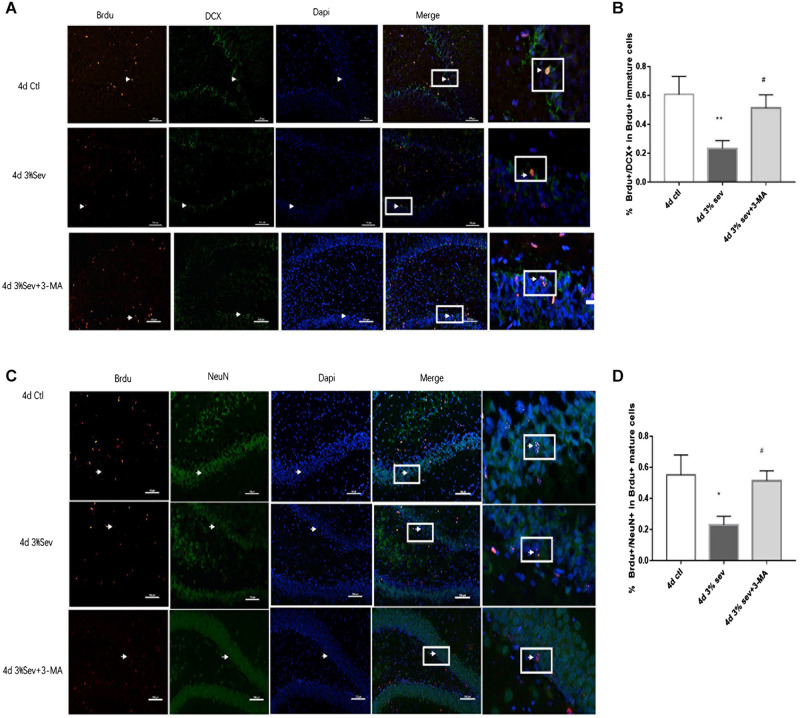
(A) LC3B inhibitor alleviated sevoflurane-induced decrease of differentiation into DCX in BrdU+ immature cells 4 days after anesthesia. (C) LC3B inhibitor alleviated sevoflurane-induced decrease of differentiation into NeuN in BrdU+ mature cells 4 days after anesthesia. (B) Quantification percentage of BrdU+/DCX+ in BrdU+ immature cells. (D) Quantification percentage of BrdU+/NeuN+ in BrdU+ mature cells. Values are presented as mean ± SD, n = 3; *P < 0.05 compared with the control 4 days group,**P < 0.01 compared with the control 4 days group, #P < 0.05 compared with the 4 days sevoflurane group. One-way ANOVA with Newman–Keuls post hoc test or Kruskal–Wallis with Dunn’s multiple comparison test was used for data analysis.